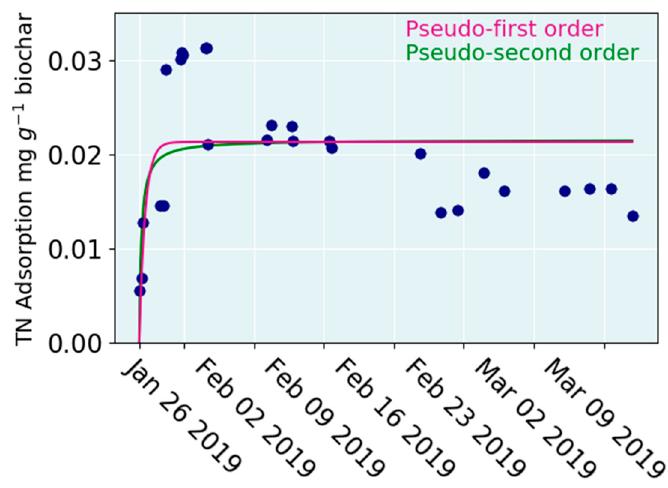
Figure 4. The adsorption of TN into the biochar reactor. The pink line is pseudo-first order and the green line is pseudo second order kinetic model fitted to the data. K ad is adsorption rate in pseudo-first order model (h − 1 ) and in pseudo-second order model (mg g − 1 h − 1 ). Q max is the maximum adsorption capacity at equilibrium (mg g − 1 biochar).